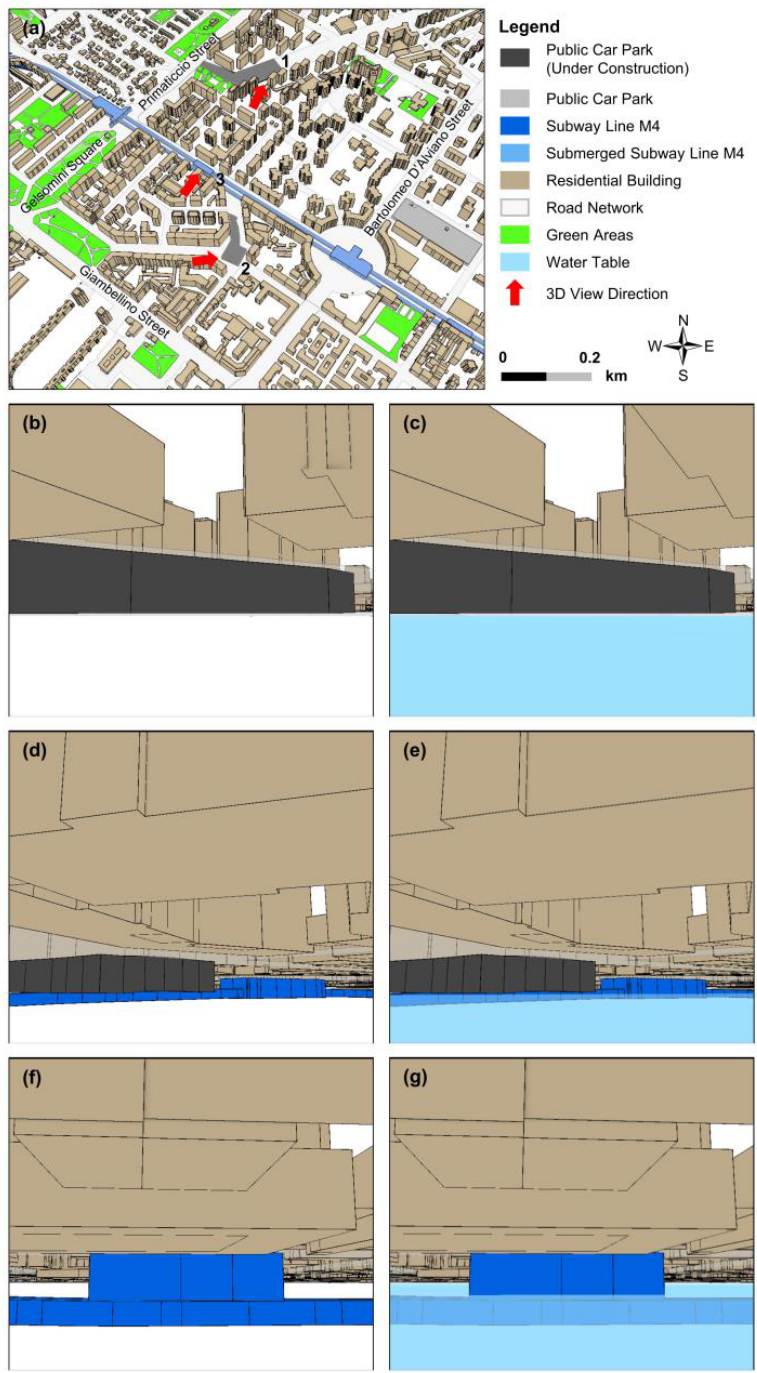
Figure 11. ( a ) 3D geographical setting of the area close to the car parks currently under construction. The car parks and the subway line M4 are visible below the road network; the names of some roads are indicated to provide more geographic details. Three-dimensional underground reconstruction of ( b ) Brasilia car park, ( d ) Scalabrini car park, ( f ) Lorenteggio 124 intervention point. GW/UIs in- teraction for ( c ) Brasilia car park, ( e ) Scalabrini car park, ( g ) Lorenteggio 124 intervention point . ( b , c